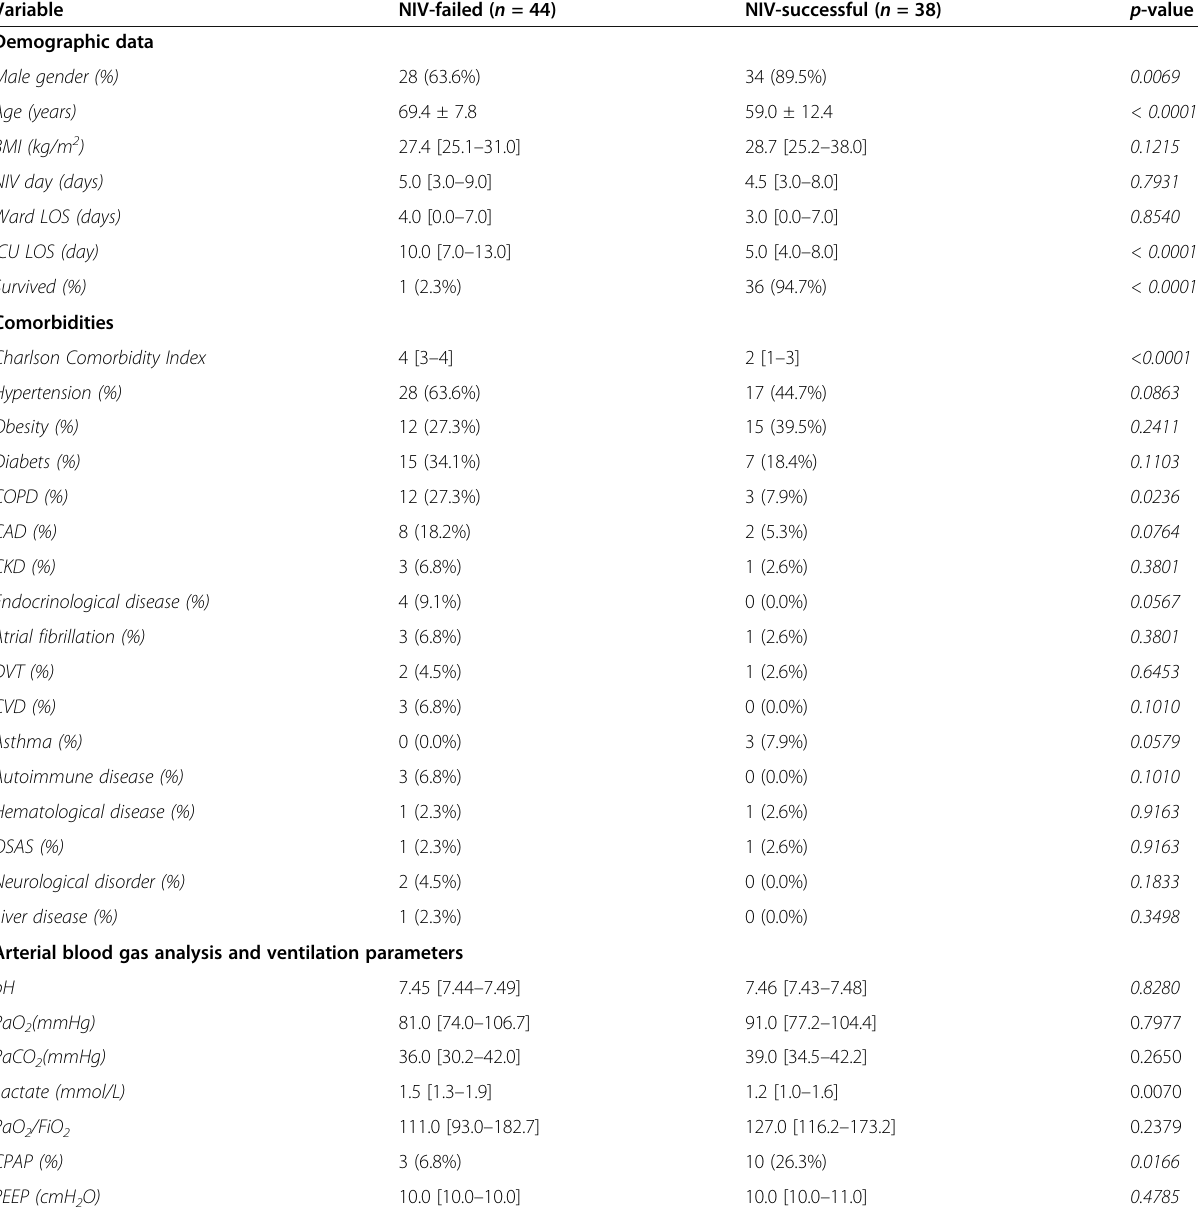
Table 2 NIV-failed vs NIV-successful groups: demographic, comorbidities, blood gas analysis, and ventilation setting parameter statistical